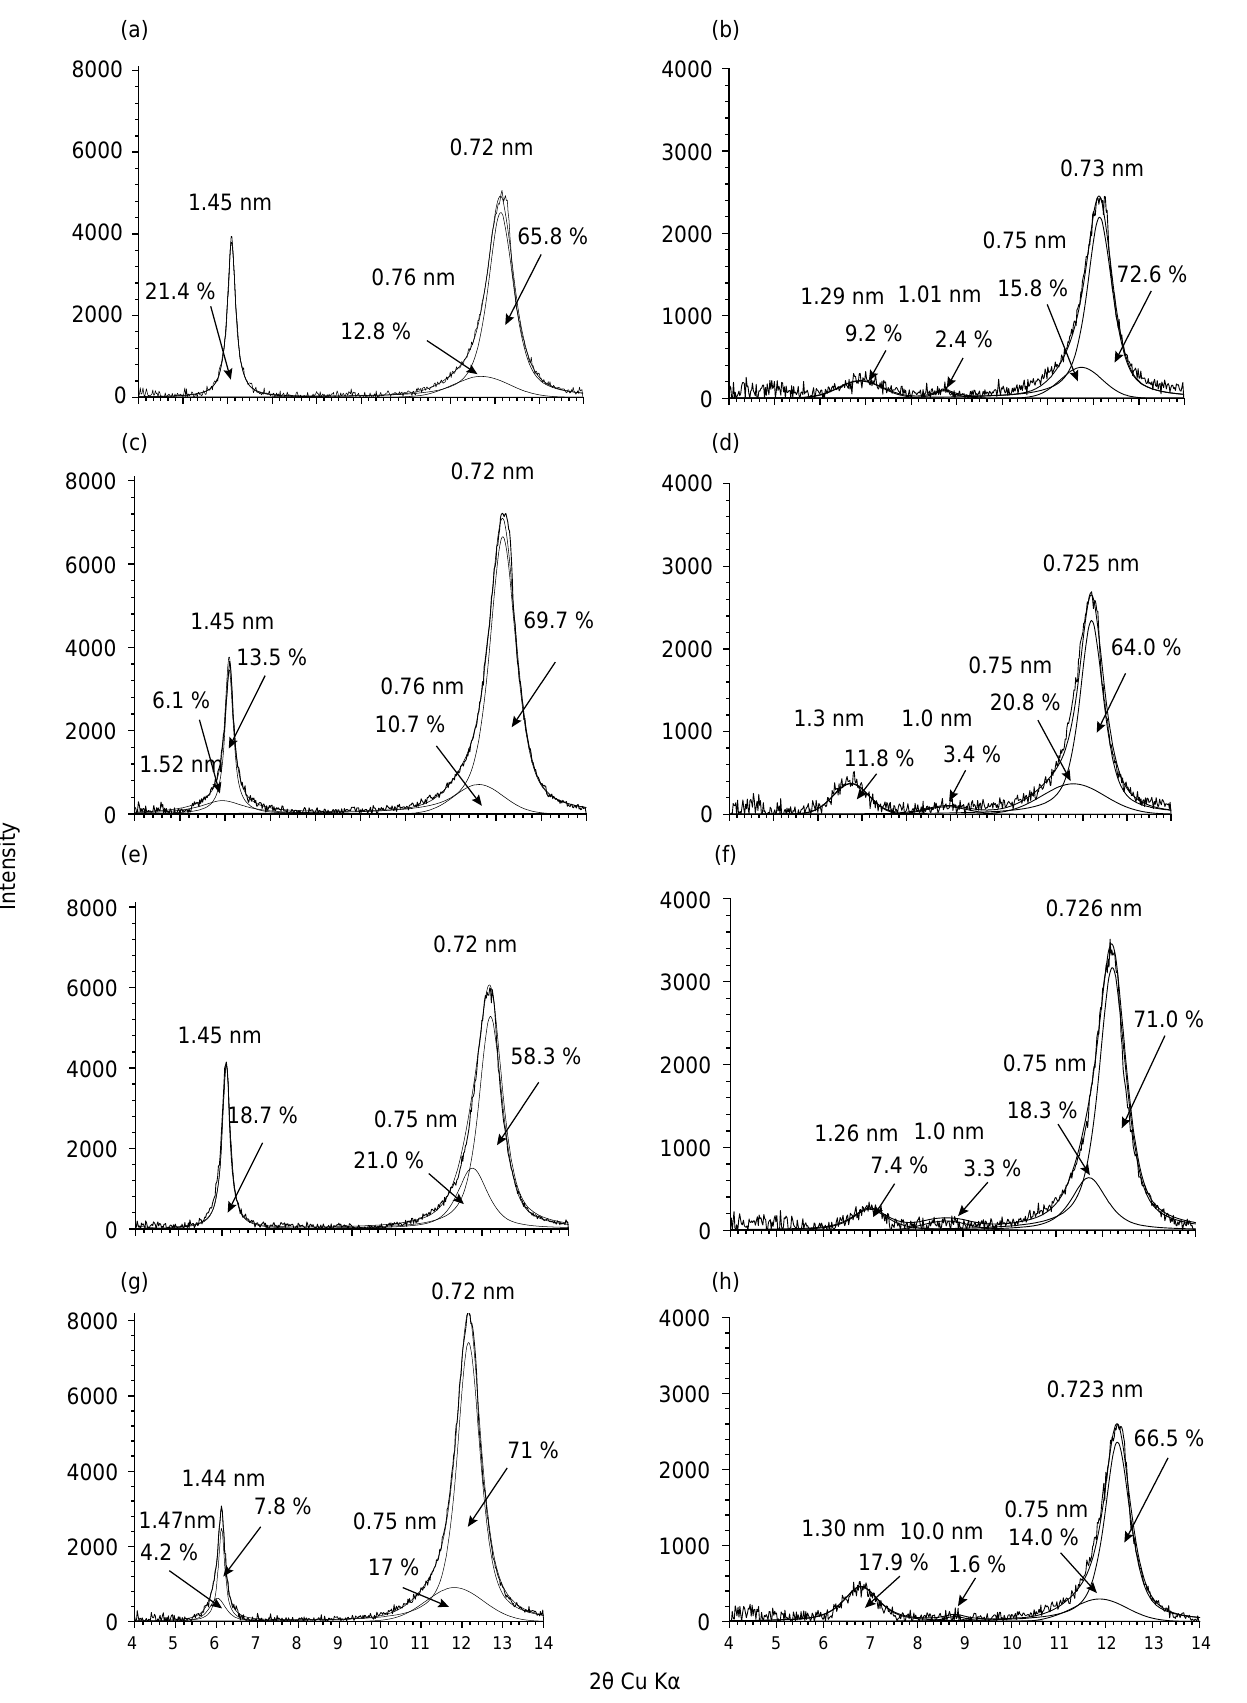
Figure 3. Modeled X-ray diffraction patterns from the Mg-saturated clay fraction and dried at room temperature (Mg-normal); K-saturated and heated to 350 °C (K 350) of a Ferralsol from Paraná, Brazil. (a) F60T0 - Mg-normal; (b) F60T0 - K350; (c) F60T90 - Mg-normal; (d) F60T90 - K350; e) F380T0 - Mg-normal; (f) F380T0 - K350; (g) F380T90 - Mg-normal; F380T90 - K350. The patterns were decomposed between 4° and 14° (2θ), corresponding to the (001) clay mineral